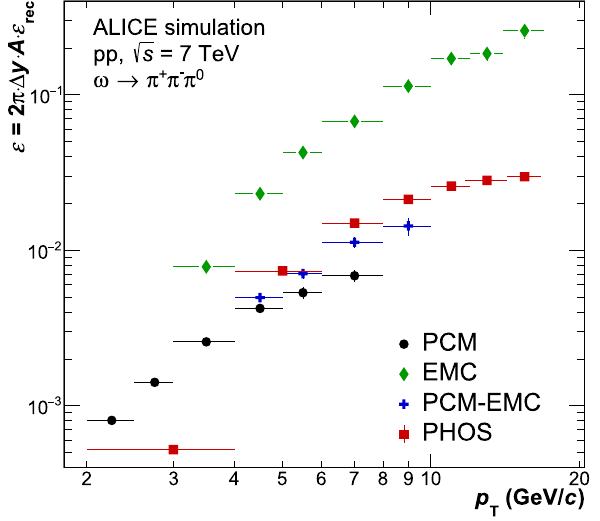
Fig. 2 Correction factors applied to the raw ω yields for each indi- cated π 0 reconstruction method. The factors include the geometrical acceptance A and the reconstruction efficiency (cid:13) rec. . In addition, a nor- malisation to unit rapidity and 2 π azimuth angle is applied to allow for a direct comparison between the different methods